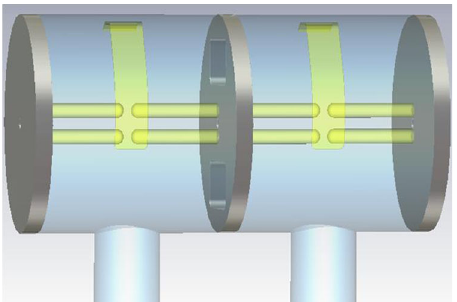
FIG. 4. Schematic of 2-cell normal conducting cavity as dis- cussed in [4].